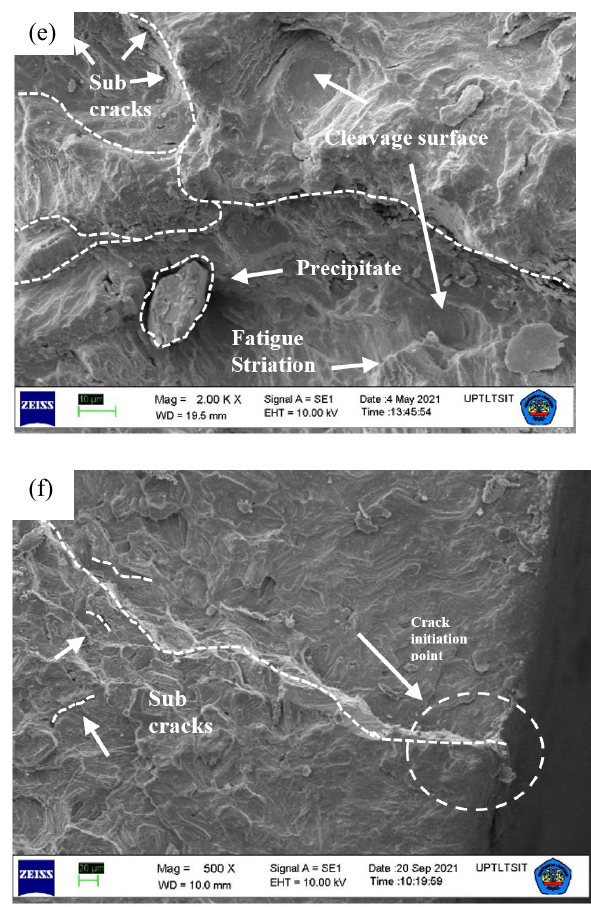
Figure 12. SEM of the fracture surface on LCF samples with a strain amplitude of 0.006